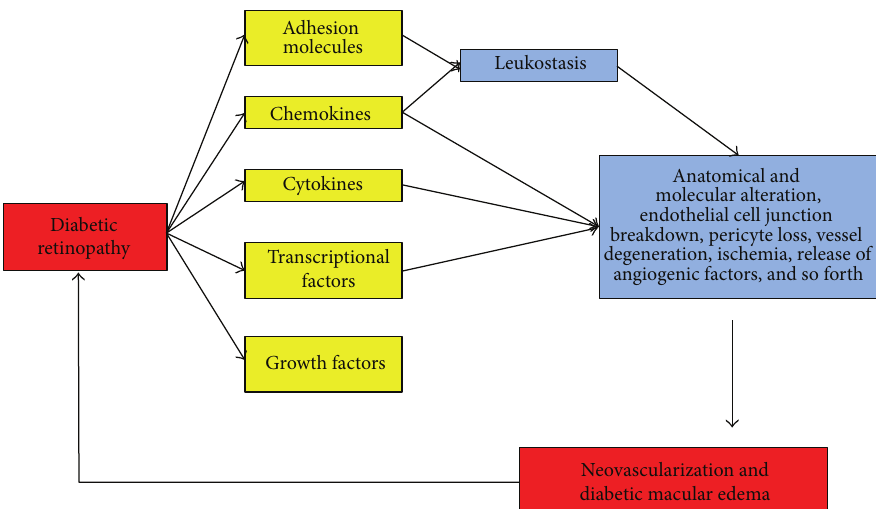
Figure 2: Role of vitreous mediators in DR progression. In DR, several inflammatory vitreous mediators are upregulated and induce anatomical changes in the retinal tissue. The structural changes enhance retinal tissue degeneration and mediate pathogenesis of DR.